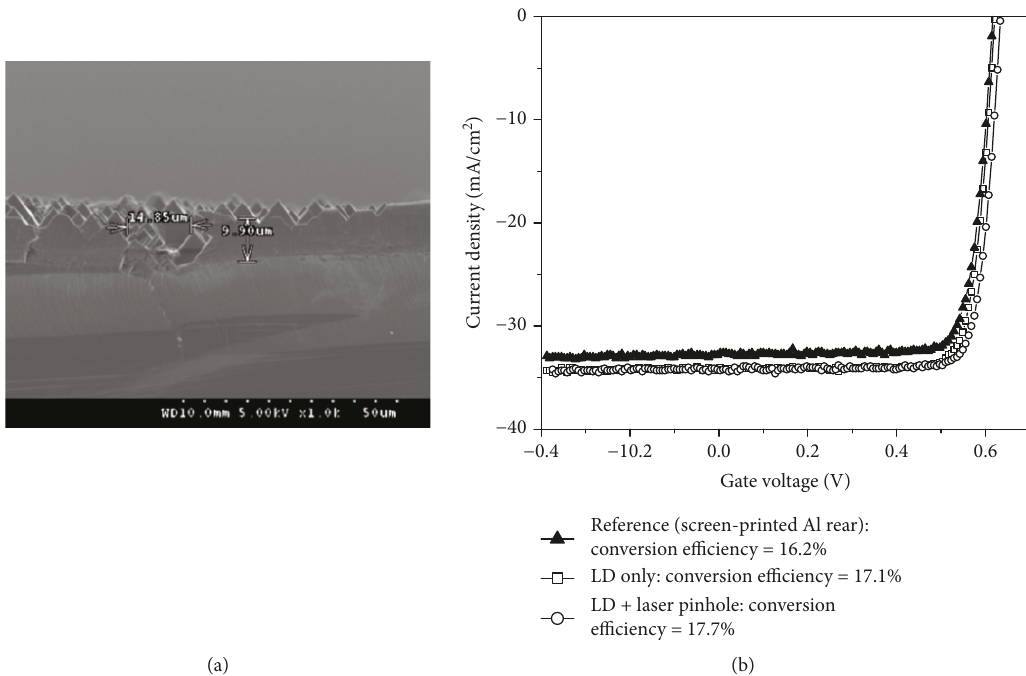
Figure 12: (a) FESEM cross-sectional image of the backside of SPMSCs with a laser pinhole process. (b) Current density vs. gate voltage curve of SPMSCs with and without laser pinhole processes is shown.